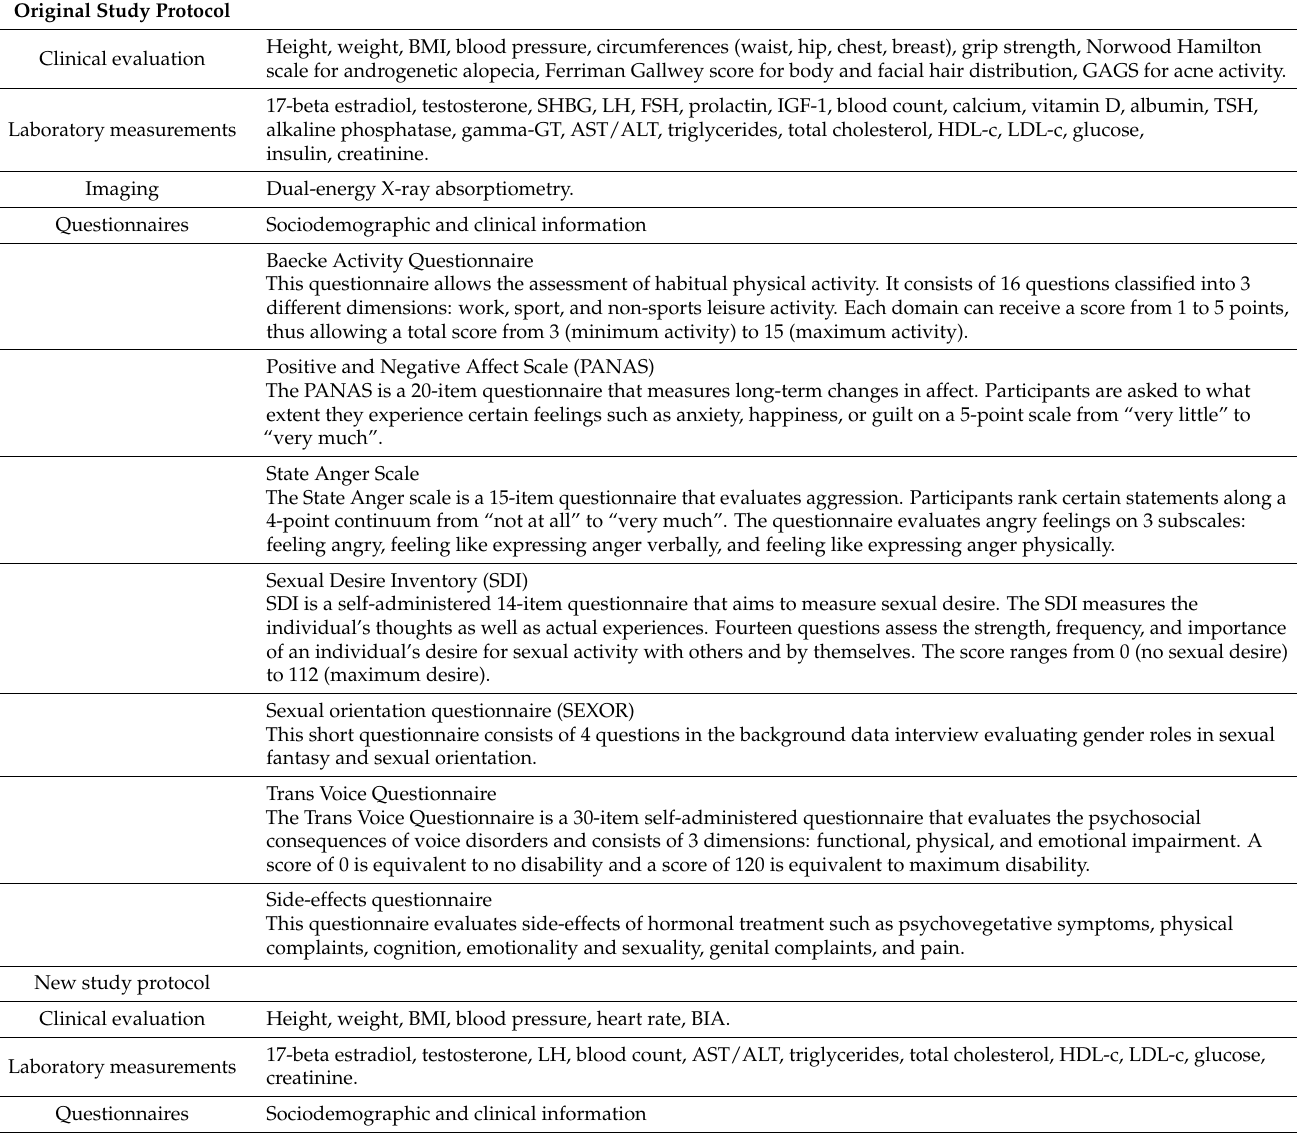
Table 2. Details of original and new ENIGI endocrine study